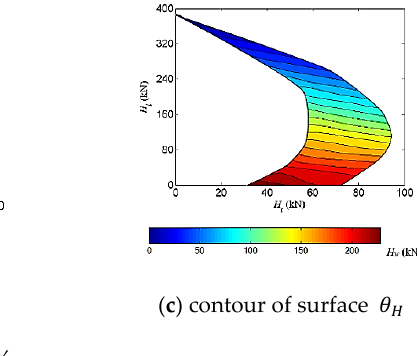
Figure 4. Capacity surfaces of tower ZY.